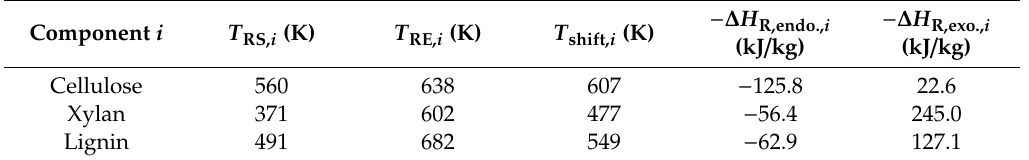
Table 2. Results for heats of reaction during pyrolysis of major components of biomass by DSC and TG.